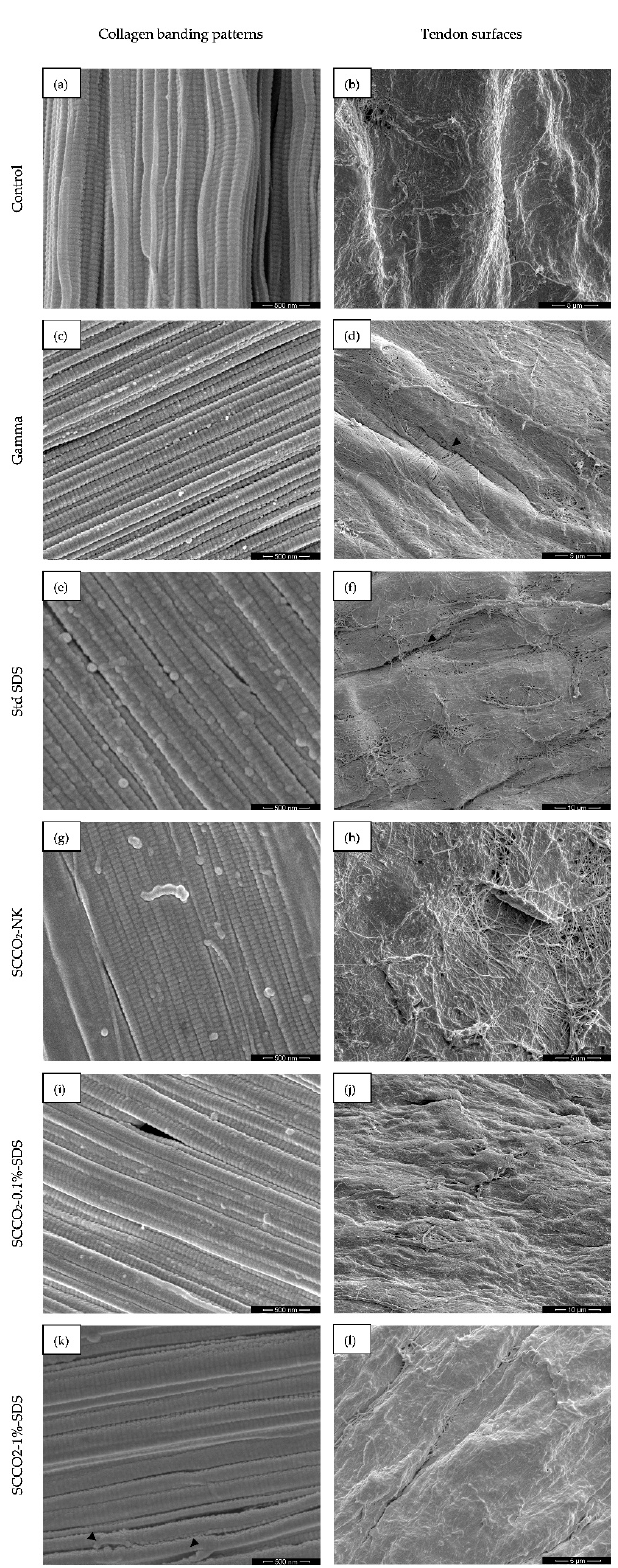
Figure 3. The typical appearances of the collagen banding patterns as observed under ~100,000 × magnification (left column, a , c , e , g , i , k ) and the tendon surfaces as observed under ~10,000 × magnification (right column, b , d , f , h , j , l ). Black arrowheads in the left column indicate breaks in collagen fibers and those in the right column indicate sites of surface breakage and exposure of underlying collagen